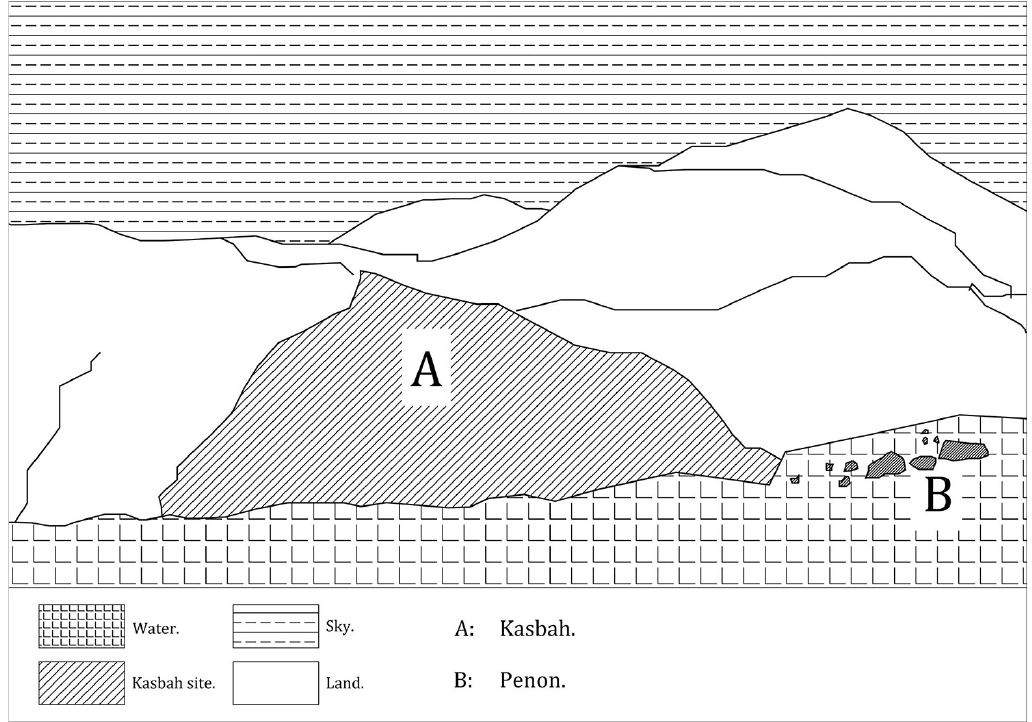
Figure 2. Frontal view of the natural landscape surrounding the original Kasbah site. Source: Produced by the authors, based on Meunier